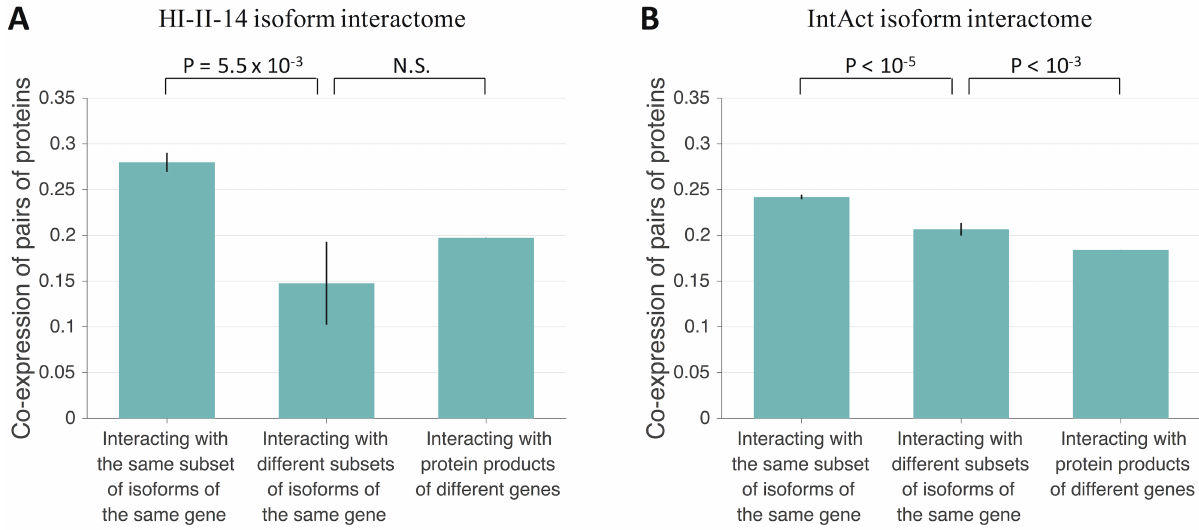
Fig 4. Tissue co-expression for protein pairs with different types of isoform interaction profiles. (A) Tissue co-expression for pairs of proteins interacting with the same subset of isoforms of the same gene, with different subsets of isoforms of the same gene, and with protein products of different genes in the predictedHI-II-14 isoform interactome. (B) Tissue co-expression for pairs of proteins interacting with the same subset of isoforms of the same gene, with different subsets of isoforms of the same gene, and with protein products of different genes in the predictedIntAct isoform interactome. Tissue co-expression was calculatedusing Pearson’scorrelationcoefficient. Only pairs in which both proteins with expressionlevels simultaneously quantified in at least 8 tissues were considered. Error bars represent standard errors of the mean. Statistical significancewas calculatedusing a